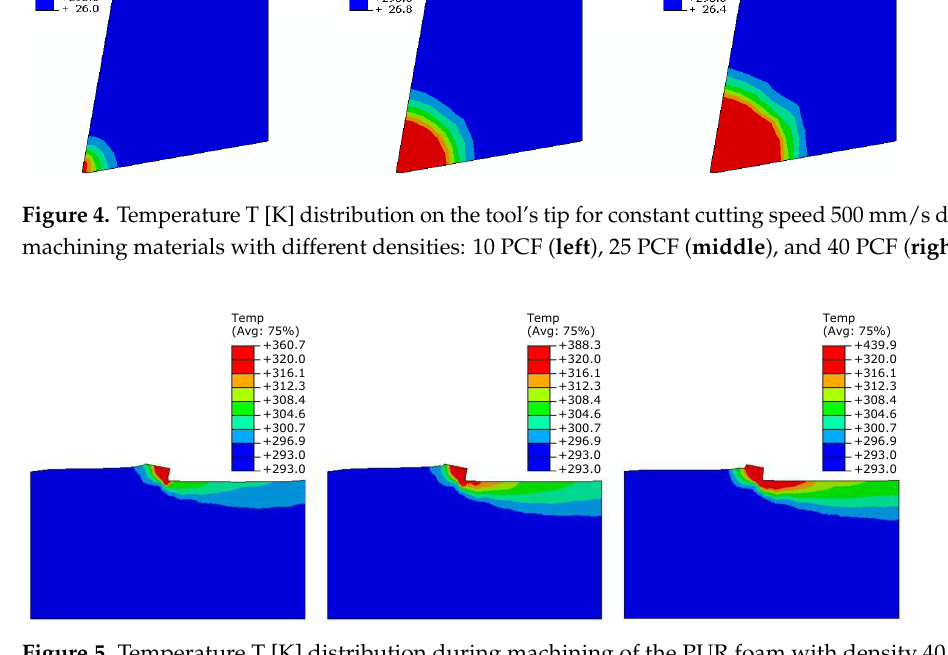
Figure 5. Temperature T [K] distribution during machining of the PUR foam with density 40 PCF : cutting speed 133 mm/s ( left ), 500 mm/s ( middle ), and 833 mm/s ( right